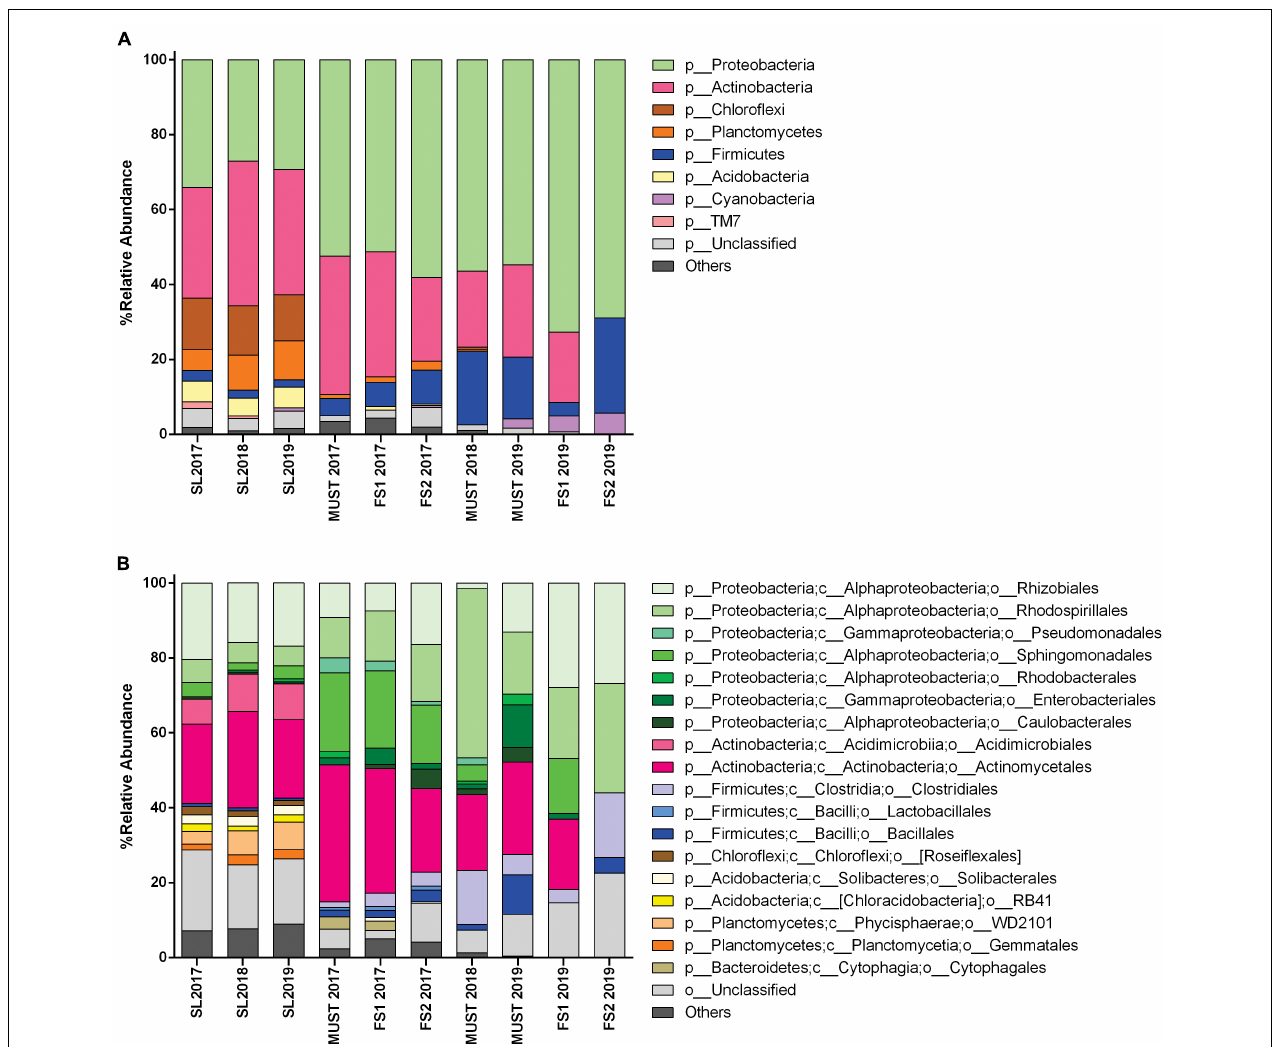
FIGURE 3 | Bacterial community structure of soil (SL) and wine samples from the Saldungaray vineyard, at the phylum level (A) ; the most abundant groups are shown at the order level (B) . Only OTUs exhibiting a relative abundance ≥ 0.5% are shown. In addition, the “others” category includes minority ( < 0.5%)